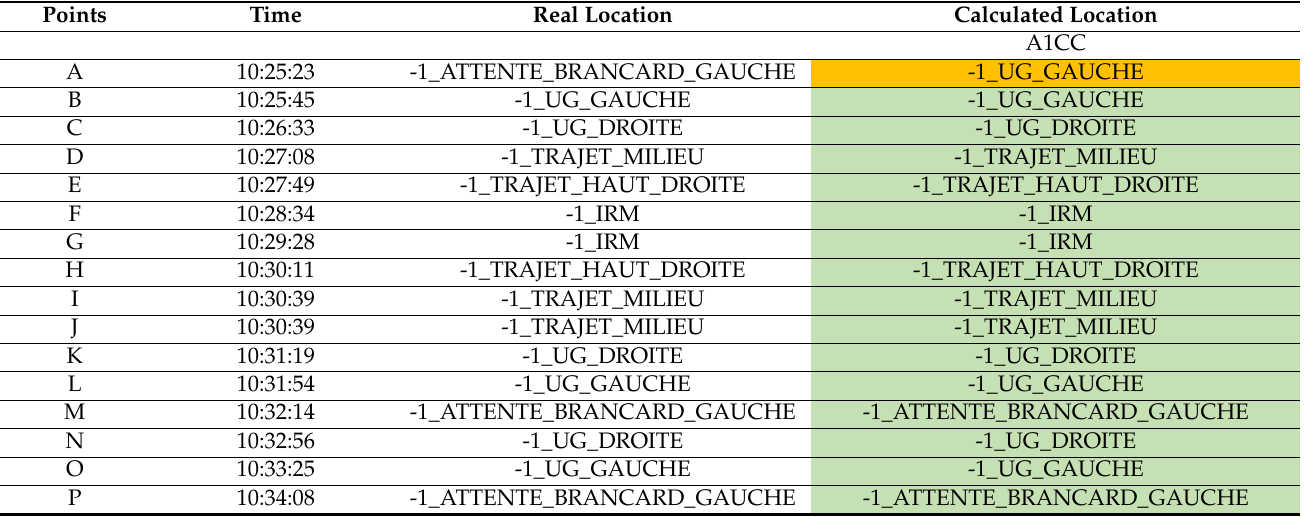
Table 1. Analyses file for positioning reliability for one tag and one